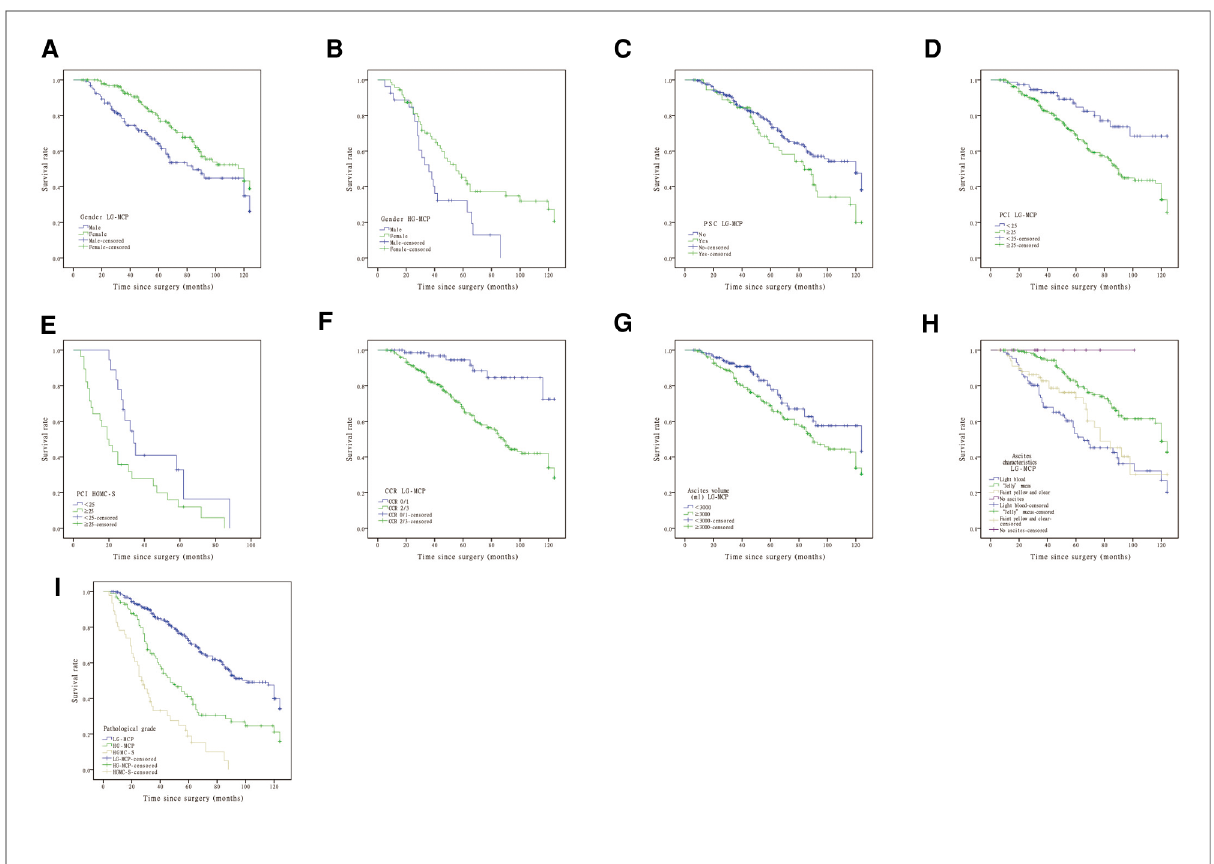
FIGURE 1 Survival curves for ( A ) gender of LG-MCP, ( B ) gender of HG-MCP, ( C ) PSC of LG-MCP, ( D ) PCI of LG-MCP, ( E ) PCI of HGMC-S, ( F ) CCR of LG-MCP, ( G ) ascites volume of LG-MCP, ( H ) ascites characteristics of LG-MCP, and ( I ) pathological grade. LG-MCP, low-grade mucinous carcinoma peritonei; HG-MCP, high-grade mucinous carcinoma peritonei; PSC, previous systemic chemotherapy; PCI, peritoneal cancer index; HGMC-S, high-grade mucinous carcinoma peritonei with signet ring cells; CCR, completeness of